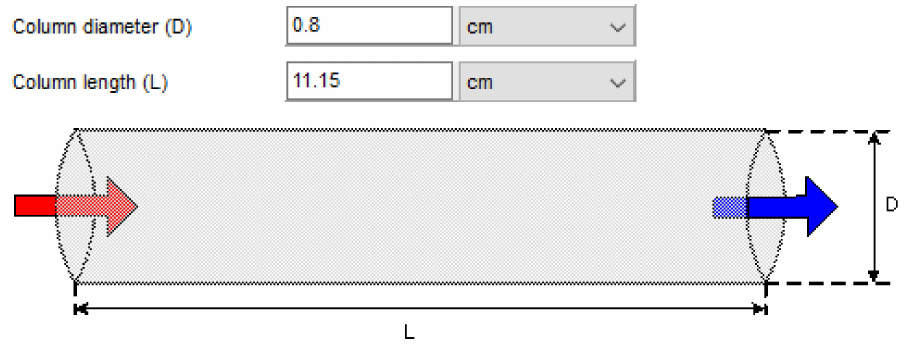
Figure 8. Lengthwise flow adsorption column for the numerical